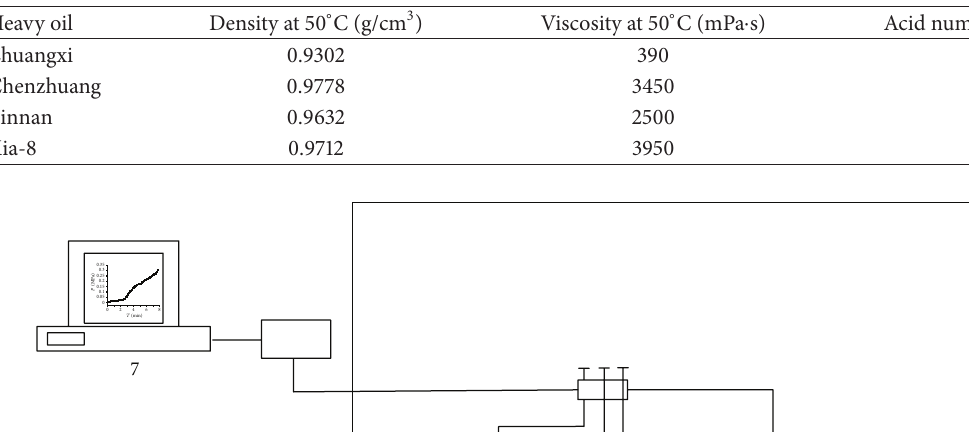
Table 1: Basic properties of four types of heavy oil.